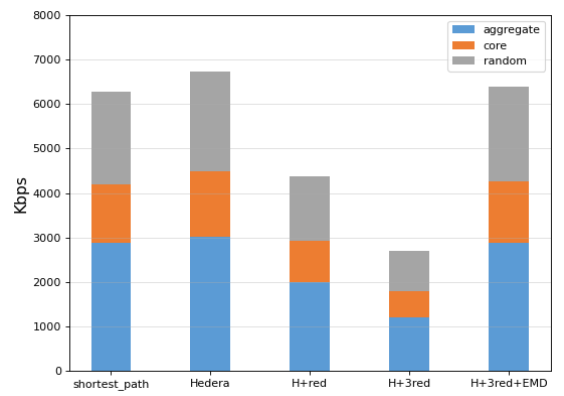
Figure 8. Bandwidth Test of A Fat-tree Data Center.